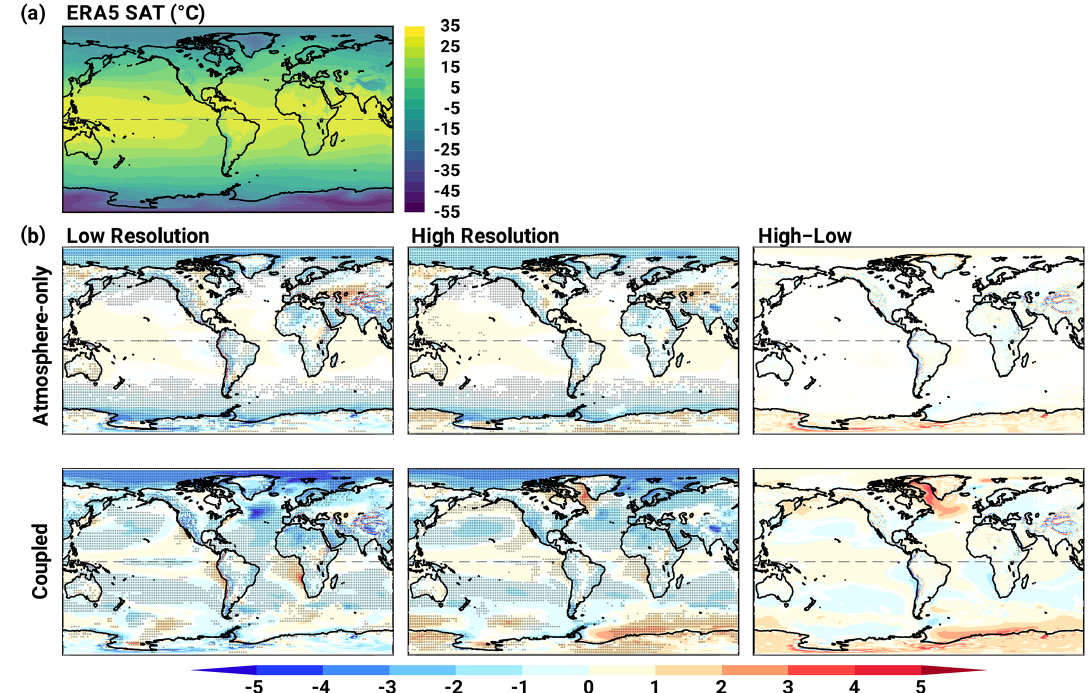
Figure 1. (a) ERA5 near-surface (2m) air temperature (SAT; in ◦ C). (b) Left and middle: multi-model ensemble mean bias in SAT (in ◦ C) in the atmosphere-only (top) and coupled (bottom) simulations at low (left) and high (middle) resolutions. Biases are with respect to ERA5 (shown in a ). Stippling masks where at least four out of the five models agree on the anomaly sign. Right: difference between the two resolutions. In all panels non-significant anomalies at the 5% level (based on a two-tailed Student’s t test) are masked white. The Equator is a dashed line in all the